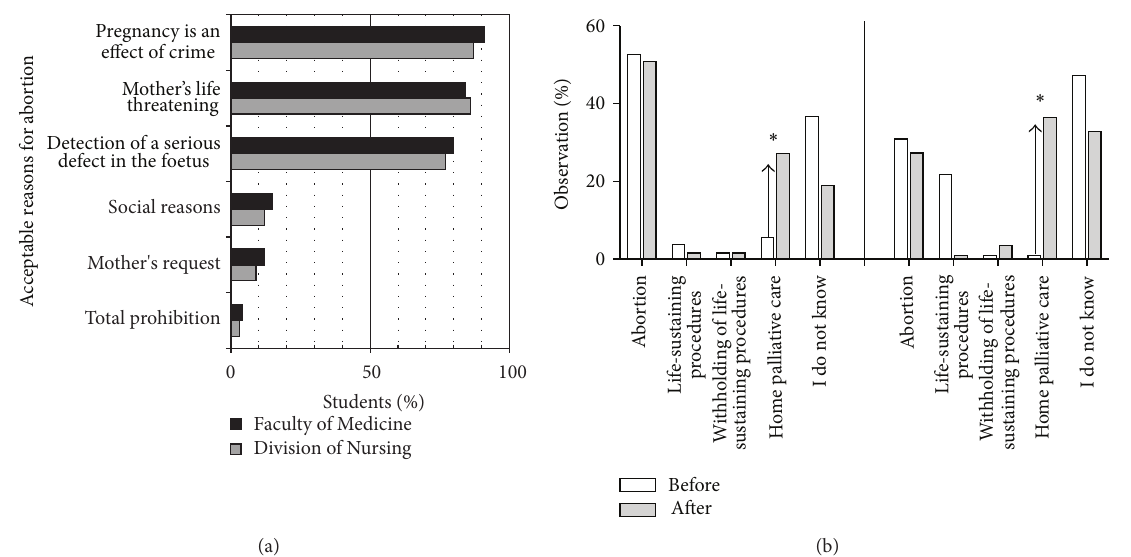
Figure 2: Students’ opinion on specific problems of pediatric palliative care. (a) Percentage of respondents acceptable reasons for abortion. (b) The percentage of Faculty of Medicine students’ (left panel) and Division of Nursing (right panel) students’ declaring choice of particular management if a lethal defect was detected in their child. ∗ 𝑃 < 0.05